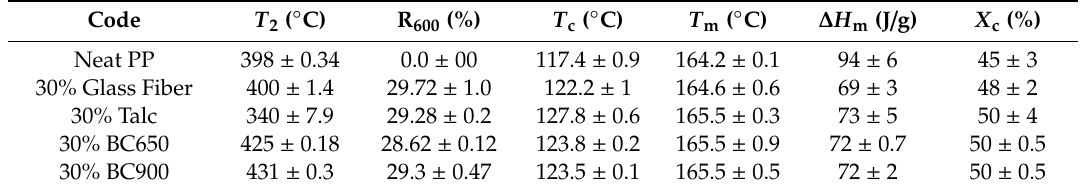
Table 2. Thermal properties of neat PP and PP-filler composites from TGA and DSC curves. Code